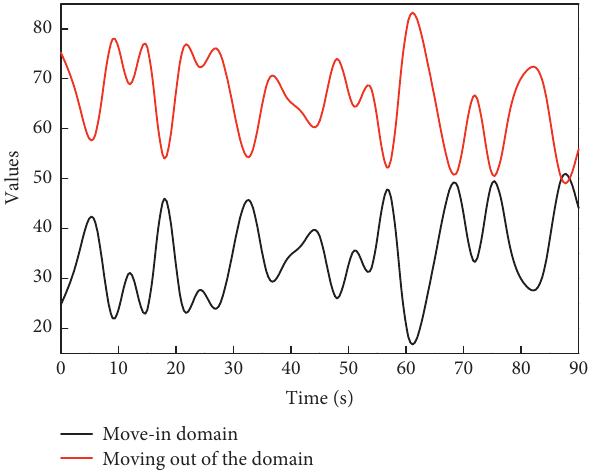
Figure 8: SDN subdomain controller load over